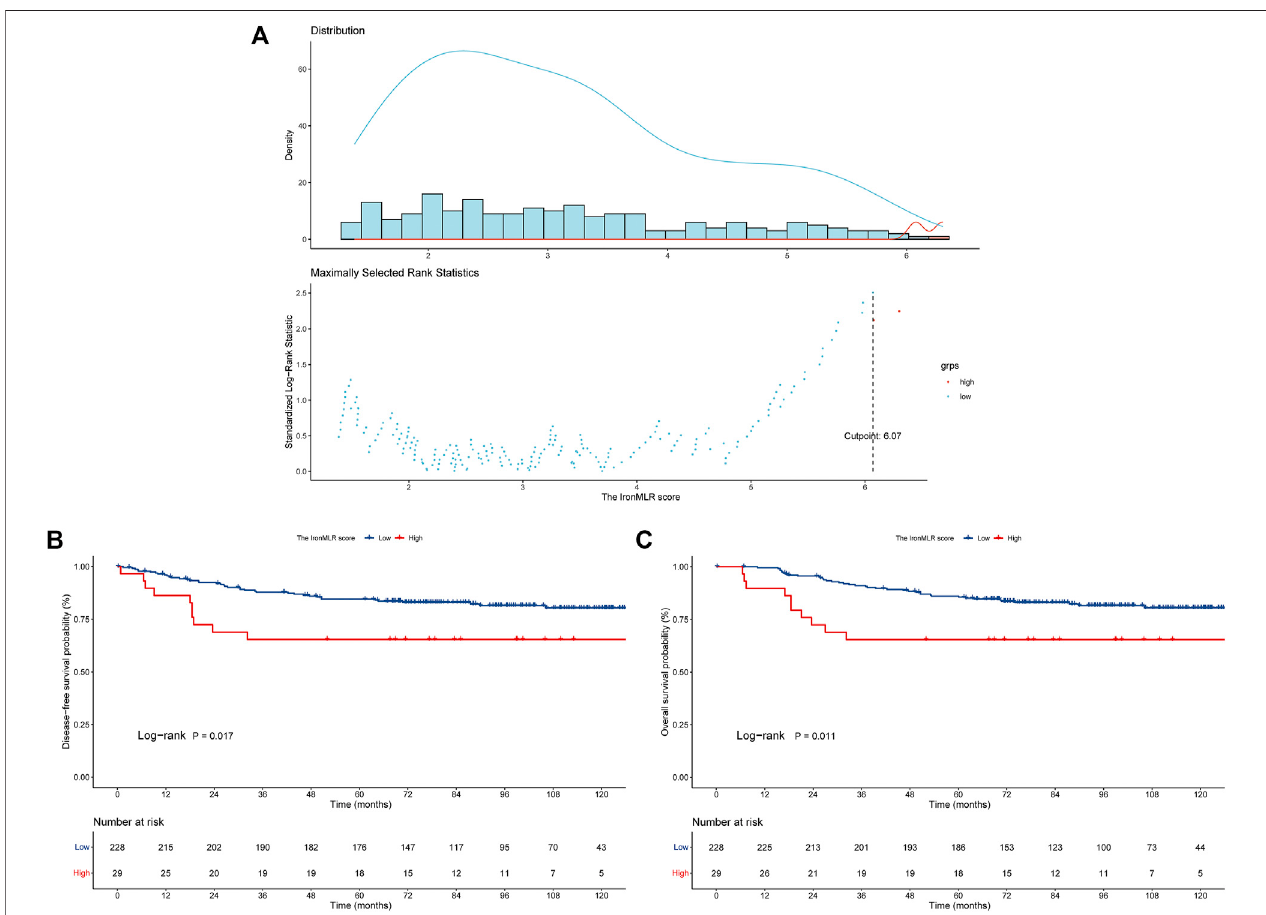
FIGURE2 | Determination of thecutoff value ofthe IronMLR score and Survivalrisk strati fi cation of patients. (A) A cutoff value of6.07 μ mol/L de fi ned by maximally selected rank statistics. (B) Survival curves for disease-free survival (DFS) between different IronMLR score groups. (C) Survival curves for overall survival (OS) between different IronMLR score